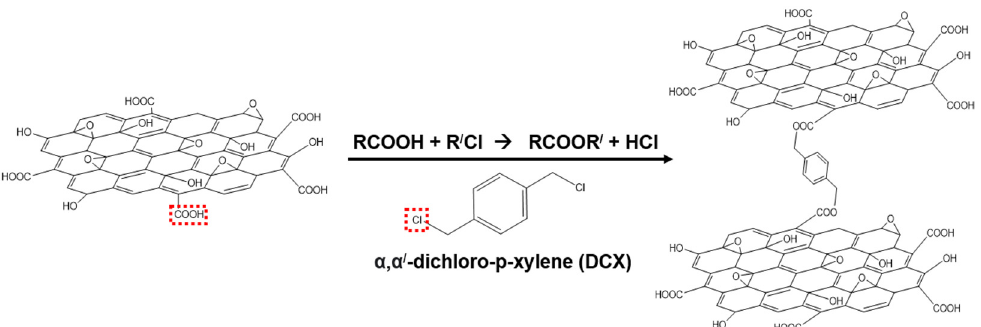
Figure 3. Mechanism of the crosslinking reaction between the graphene oxide (GO) nanosheets and α , α /-dichloro-p-xylene (DCX).